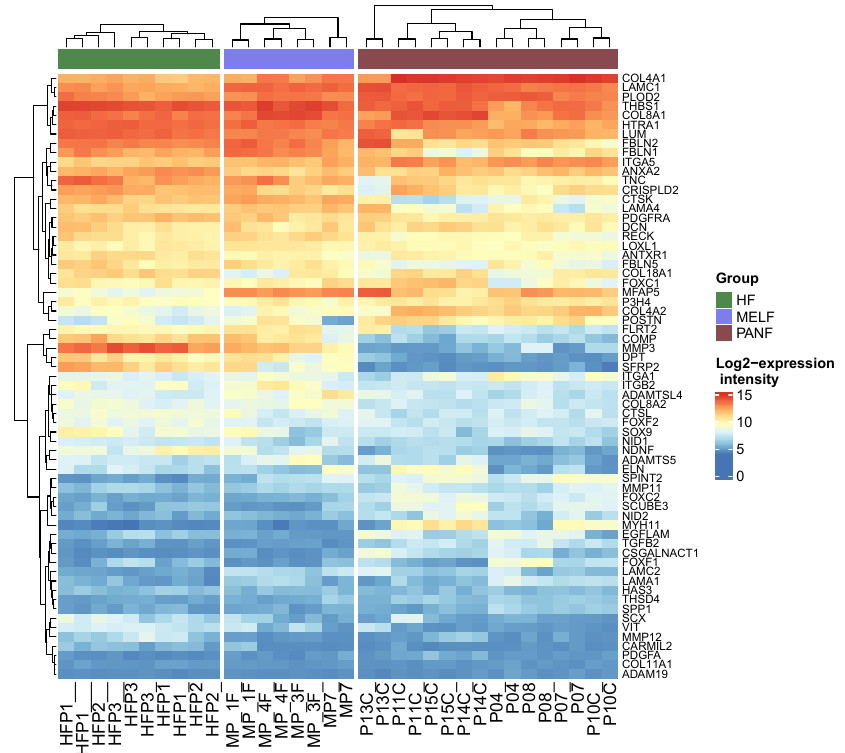
Figure 8. Heat map demonstrating differential expression of genes responsible for extracellular ma- trix organization in PANF and MELF compared to normal fibroblasts (GO term GO:0030198, extra- cellular matrix organisation).